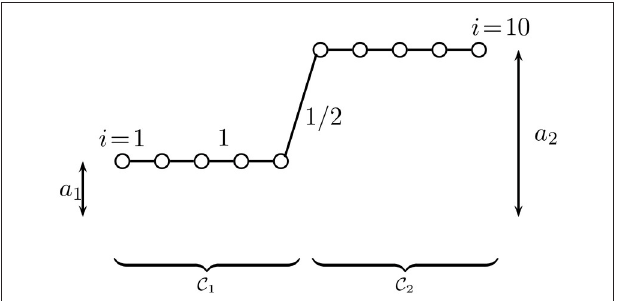
[ i ] (cf. Equation 4) [ i ] + a 2 I C 2 1